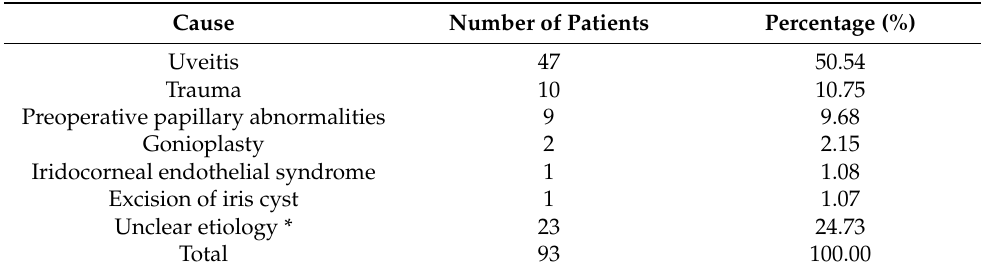
Table 1. Etiology of the 93 patients with pupillary abnormalities after PKP.